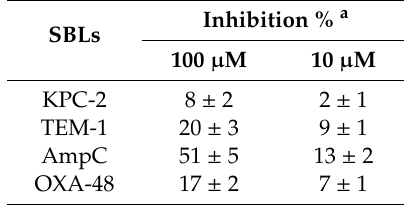
Table 2. Inhibitory activities of compound 5l against representative serine β -lactamases (SBL)